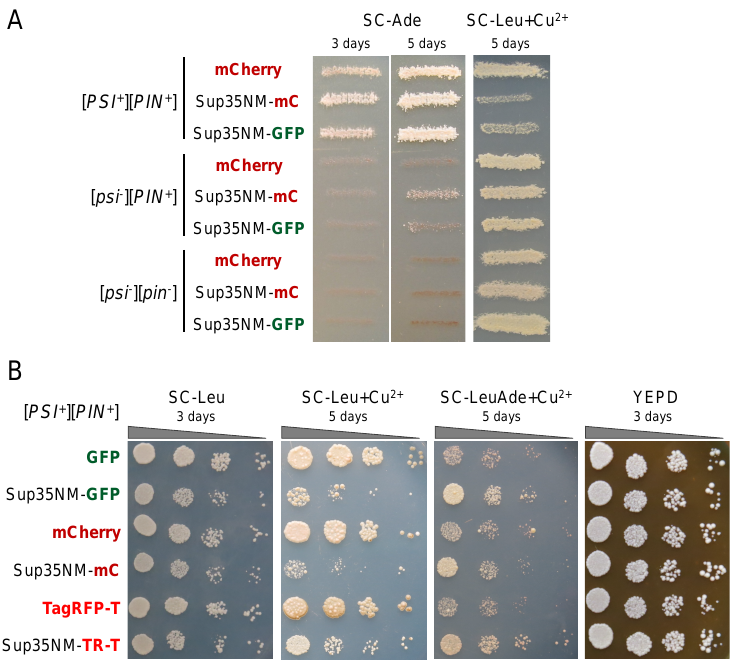
Figure 2. Sup35NM-mCherry protein retains the prion properties and does not cause the loss of [ PSI + ]. ( A ). Phenotypic assay performed by replica plating of OT56 [ PSI + ][ PIN + ], 1-OT56 ([ psi - ][ PIN + ]), and 2-OT56 ([ psi - ][ pin - ]) strains, transformed with vectors pRS315CmC, pRS315CNMmC, and pRS315CNMG for copper-inducible expression of mCherry , SUP35NM-mCherry , and SUP35NM- GFP , respectively. Similar to Sup35NM-GFP, Sup35NM-mCherry enhances nonsense-suppression and prion toxicity in the [ PSI + ][ PIN + ] strain and promotes de novo [ PSI + ] formation in the [ psi - ][ PIN + ] strain. ( B ). Tenfold serial dilutions of the OT56 transformed with vectors from A, as well as pRS315CG, pR15CUP-NM-yTagRFP-T, and pR15CUP-yTagRFP-T for the inducible expression of GFP , SUP35NM- yTagRFP-T , and yTagRFP-T ,